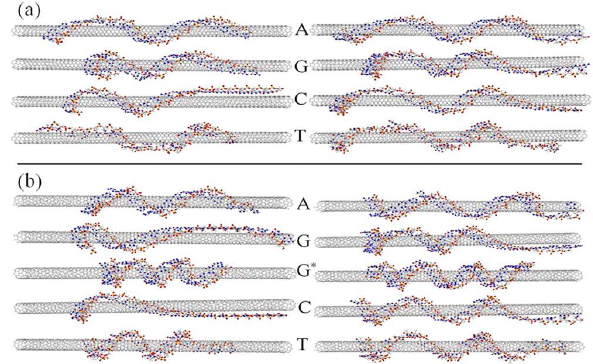
Figure 1. Theoretical structural models of single-stranded DNA (ssDNA)-single-walled nanotube (SWNT), SWNT hybrids with different DNA bases. ( a , b ) show (6,5) and (9,1) SWNTs, respectively. Left and right images show 23 and 29 mers of ssDNA, respectively. G* indicates the guanine mer with fixed ends. The most stable structures with the strongest binding energies based on π–π interactions are represented. The model indicated that the wrapping of DNA molecules is not homogeneous, and helical wrapping is not ideal (reprinted from reference [27] with permission).